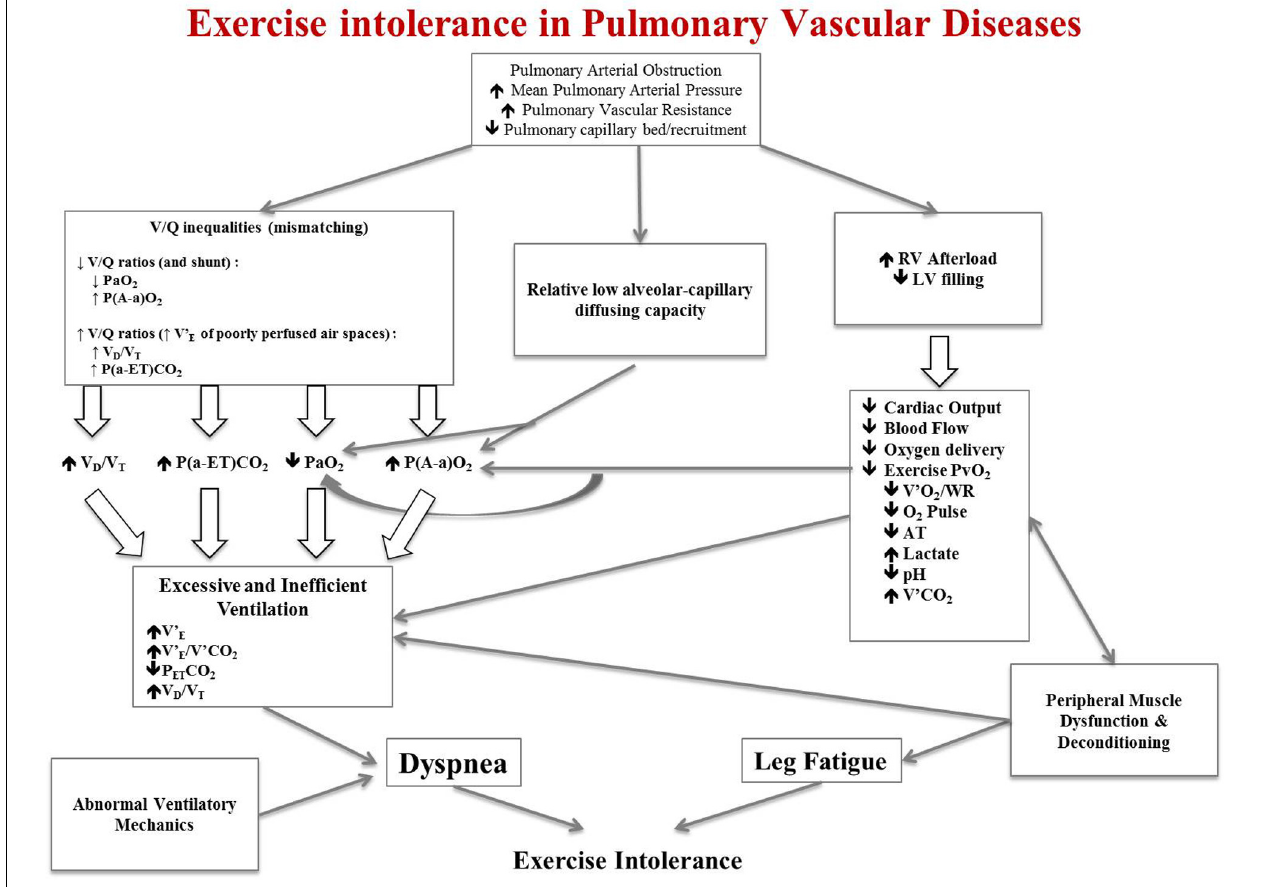
FIGURE 1 | Schematic pathophysiologic pathway leading to exercise intolerance and exertional dyspnea in pulmonary hypertension. RV, right ventricle; LV, left ventricle; V’ E , minute ventilation; V’ E /V’CO 2 , ratio of minute ventilation to carbon dioxide production; P ET CO 2 , end-tidal pressure of carbon dioxide; V D /V T , dead space to tidal volume fraction; V’O 2 , oxygen consumption; WR, work rate; O 2 pulse, V’O 2 to heart rate (HR) ratio; V’CO 2 , carbon dioxide production; PvO 2 , venous pressure of oxygen; PaO 2 , arterial partial pressure of oxygen; PaCO 2 , arterial partial pressure of carbon dioxide. This is an original figure, no permission is